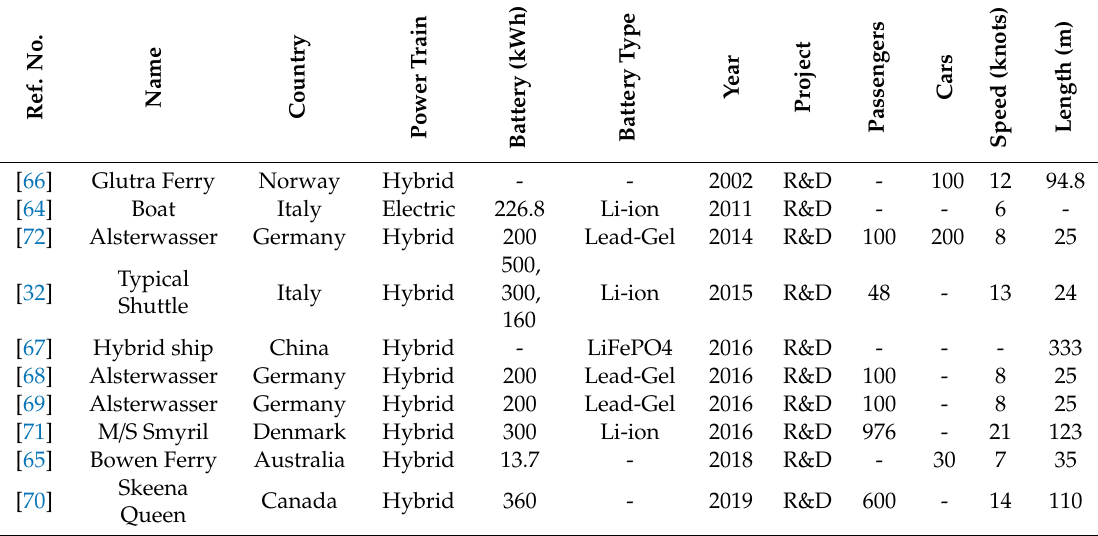
Table 3. Case studies through research and